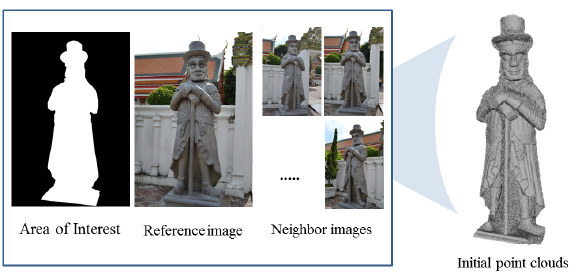
Figure 7: Point clouds obtained from multi-view images using MICMAC software.